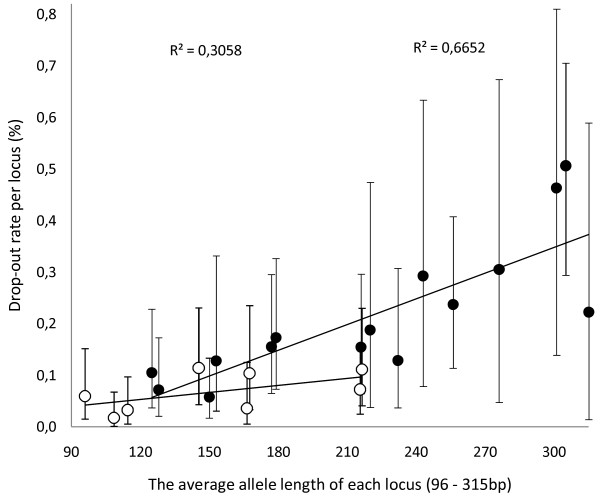
Dropout rates in autosomal short tandem repeat (STR) analyses. IF (black circles) and MF (white circles), plotted against the average allele length of each locus. Limit of detection was 100 relative fluorescence units (RFU).